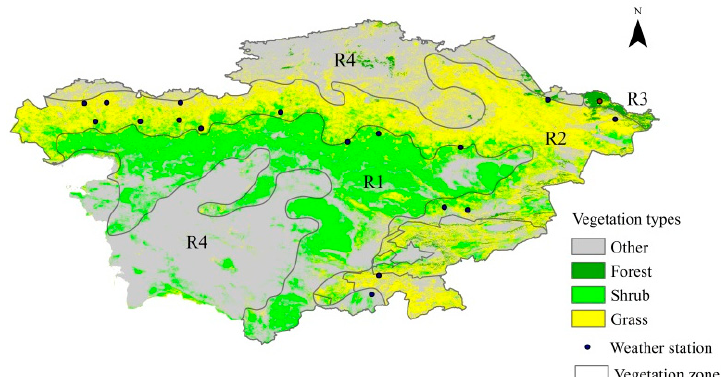
Figure 2. Vegetation zones and weather stations in the study area.